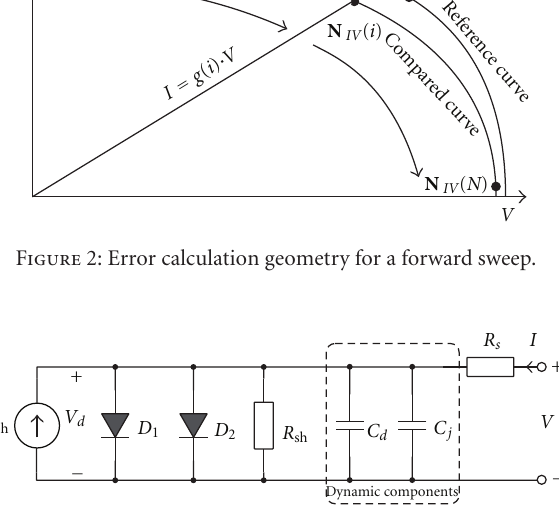
Figure 3: Two-diode solar cell model extended by two